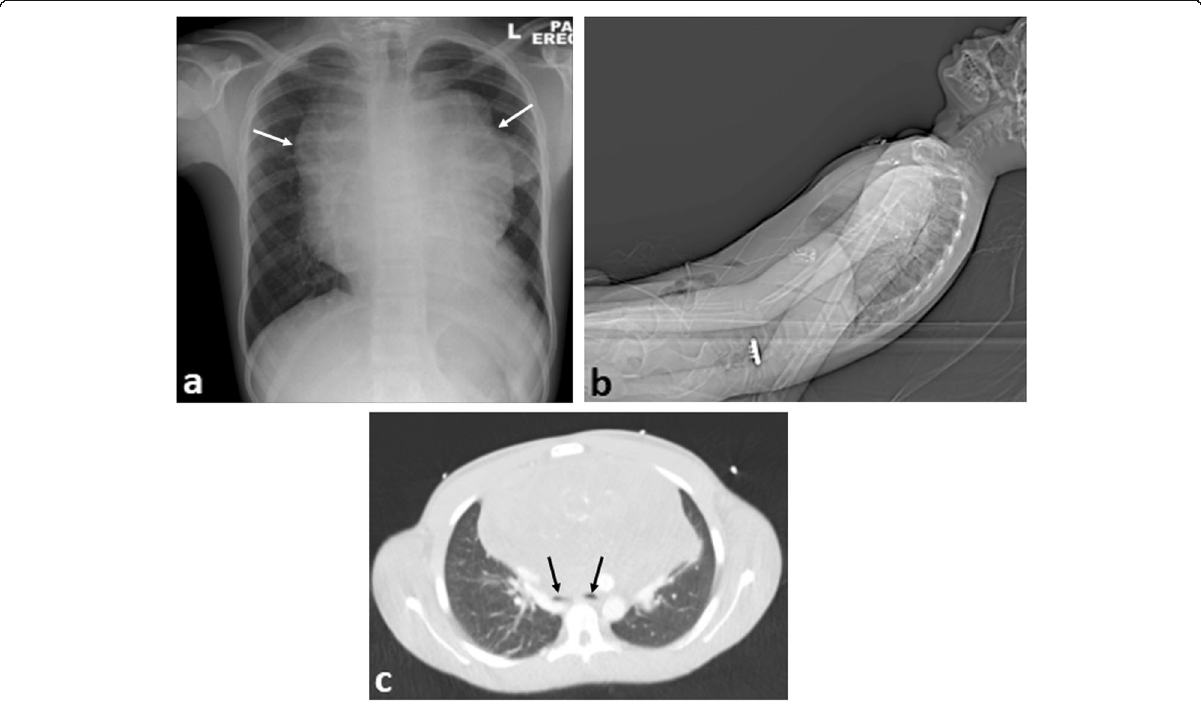
Fig. 7 A 15-year-old boy with difficulty breathing and stridor presented with a large anterior mediastinal mass secondary to Hodgkin ’ s lymphoma. a Erect plain chest radiograph reveals a widened mediastinum (arrows). b Lateral view of the topogram from the CT scout image demonstrates the semi-upright positioning of the patient in the scanner because of reduced air entry on lying supine. c Axial CT imaging (lung windows) at the carina demonstrates marked airway compression of the main bronchi (black arrows) from the anterior mediastinal